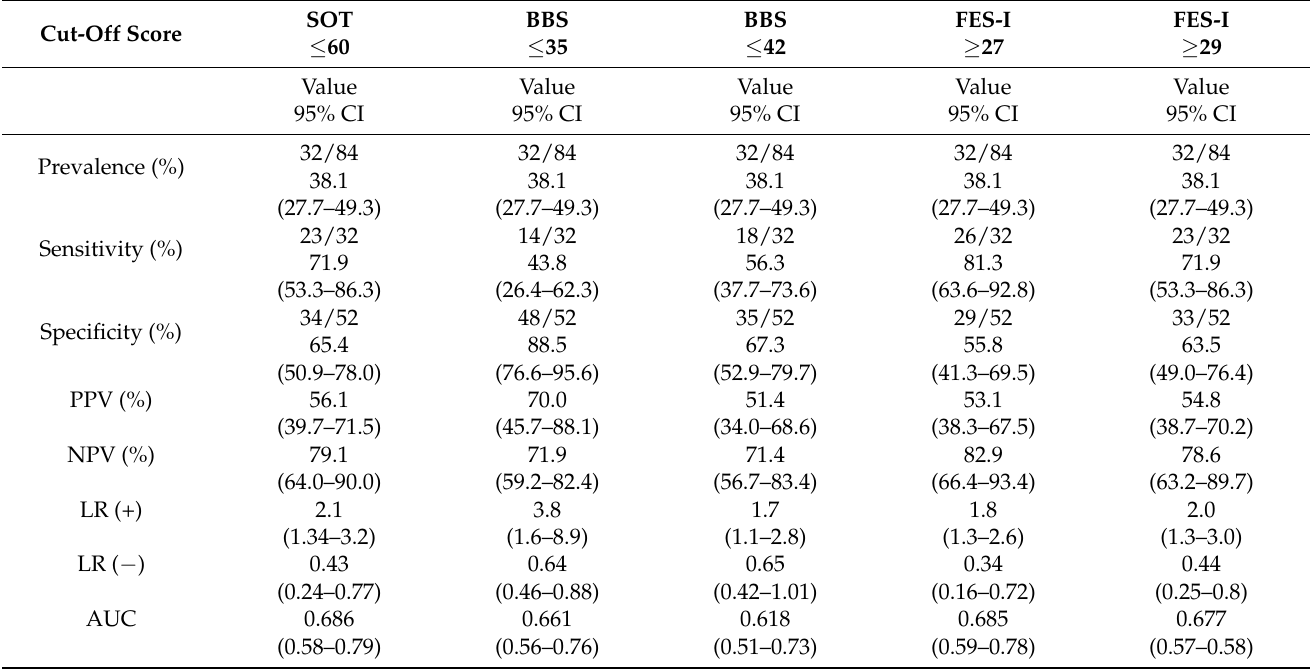
Table 2. The optimal cut-off scores for SOT, BBS, and FES-I using the Youden